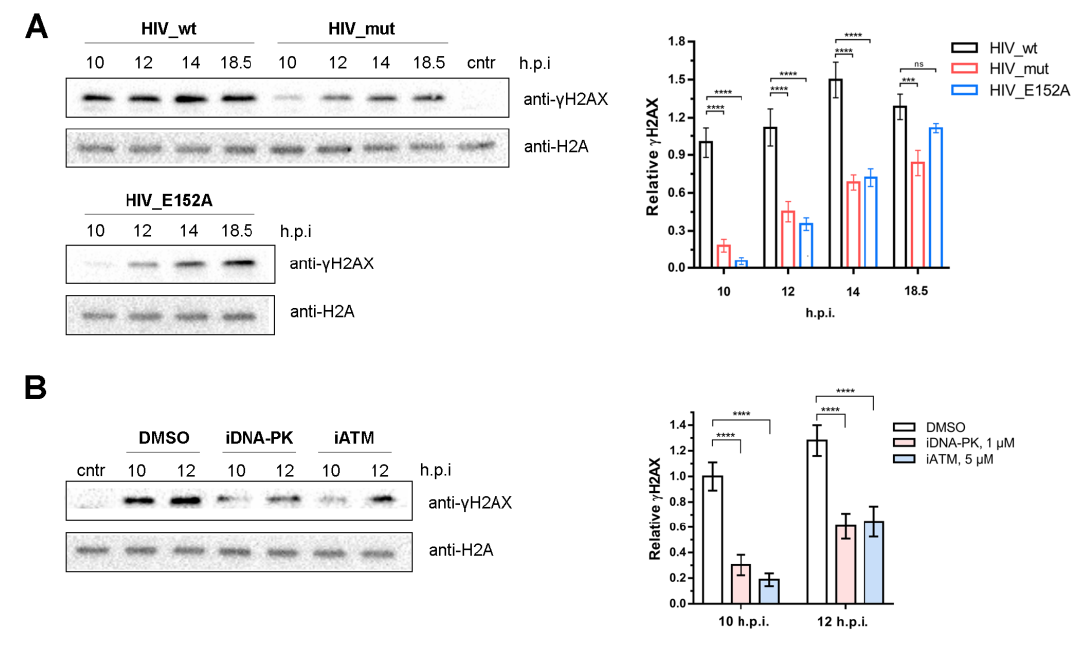
Figure 6. γ H2AX as a marker of HIV-1 post-integrational DNA repair. ( A ) Kinetics of γ H2AX formation in 293T cells transduced by HIV_wt, HIV_mut, or HIV_E152A analyzed using Western blot (left) and its quantitative analysis (right). HIV_mut contains IN with E212A/L213A substitutions defective in Ku70 binding and PIR initiation. HIV_E152A contains IN with E152A substitution defective in catalytic activity (impaired integration). The sample, designated cntr, was not transduced by any pseudovirus. Mean values ± SD of three independent experiments are presented. ( B ) γ H2AX formation in 293T cells transduced by HIV_wt and treated with Nu7441 (iDNA-PK, 1 µ M) or Ku- 55933 (iATM, 5 µ M) analyzed using Western blot (left) and its quantitative analysis (right). Samples designated as DMSO were transduced with pseudovirus but without any inhibitor, and DMSO was added to them in the same amount as to the samples treated with inhibitors. The sample denoted as cntr was treated with DMCO but not transduced by pseudovirus. Mean values ± SD of three independent experiments are presented. Significance was determined by two-way ANOVA with Sidak’s correction for multiple comparisons, ns—not significant, *** = adj. p -value < 0.001, **** = adj. p -value <